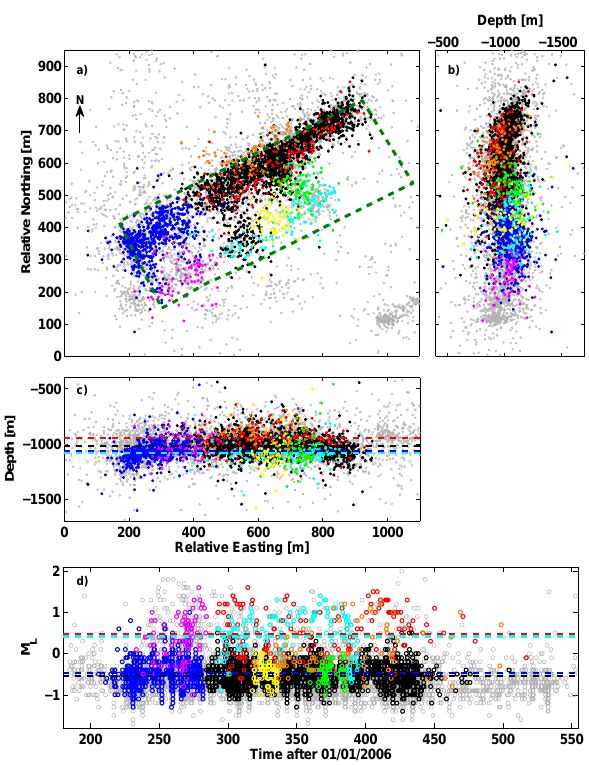
Fig. 8. Result of the single linkage cluster analysis (absolute event locations). Colour coded are the eight largest clusters found with the single linkage approach in (a) map view, (b) N–S depth section and (c) E–W depth section. (d) Magnitude over time plot of the events. In all figures the grey circles indicate the events in the catalogue not belonging to the eight largest clusters. Broken line in (c) indicates the mean depth of the respective cluster. Broken line in (d) indicates the mean magnitude of the respective cluster. For clarity only the mean values of the four largest clusters are depicted in (c) and (d) . Note the exaggeration of the N–S and E–W axes in (b) and (c) , respectively, with respect to the depth